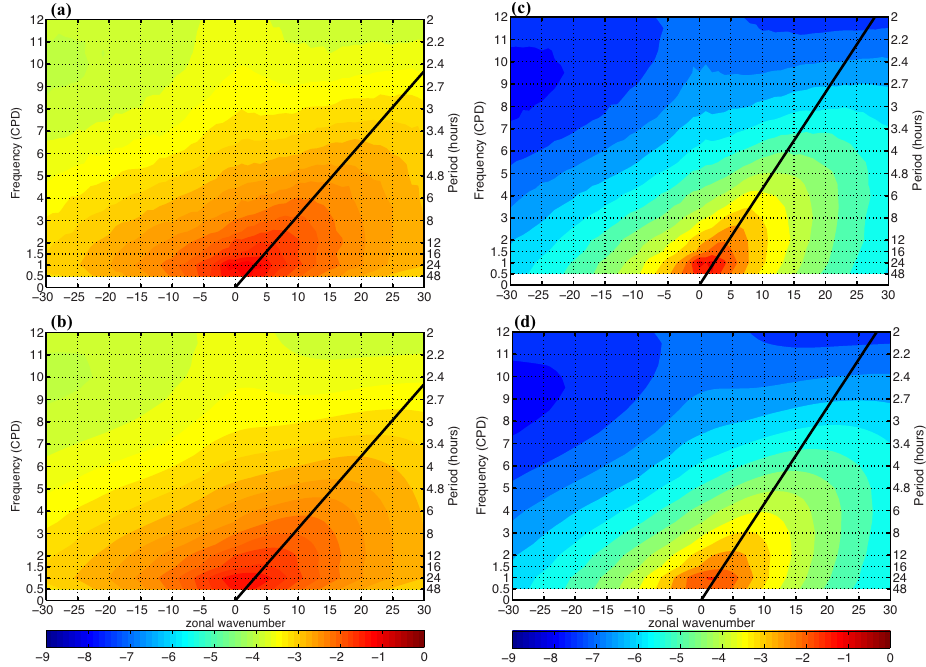
Figure 8. Top: zonal wave-number-frequency power spectra (with base-10 logarithmic transform) of the hourly precipitation throughout the warm season summed over the focus domains in (a) East Asia and (c) North America. Bottom: the same as in the left panels except for smoothed power spectra for (b) East Asia and (d) North America. The y axis on the left is the frequency in units of CPD (cycle per day), and on the right the time period in hours. The black solid lines points out the ridges of power spectra.